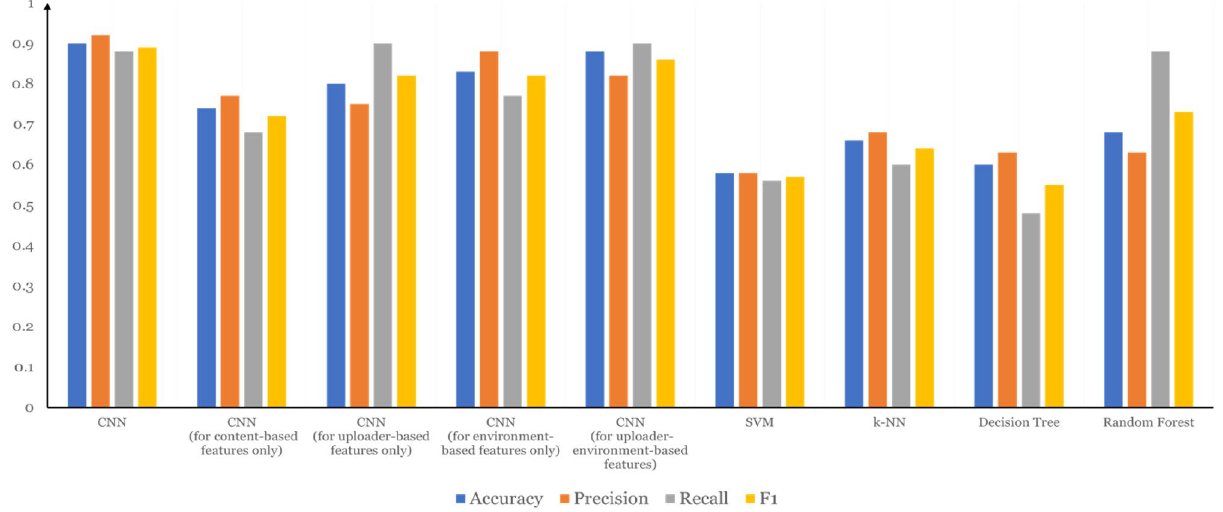
Figure 4. Experiment results from different